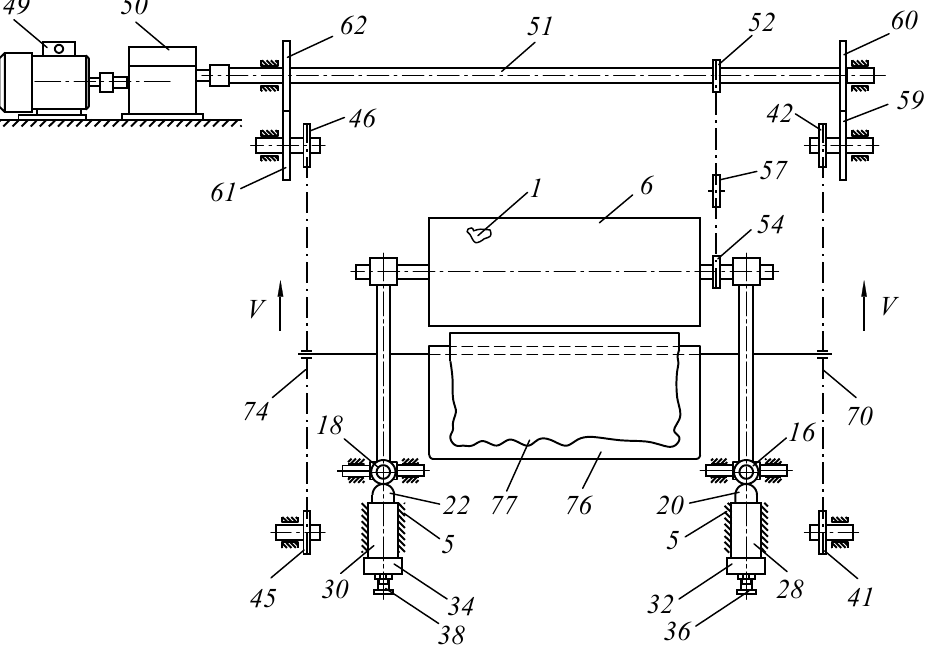
Figure 3. The scheme of transportation of the processed material by the working rolls in contact with the package of processed leather semi-finished products.